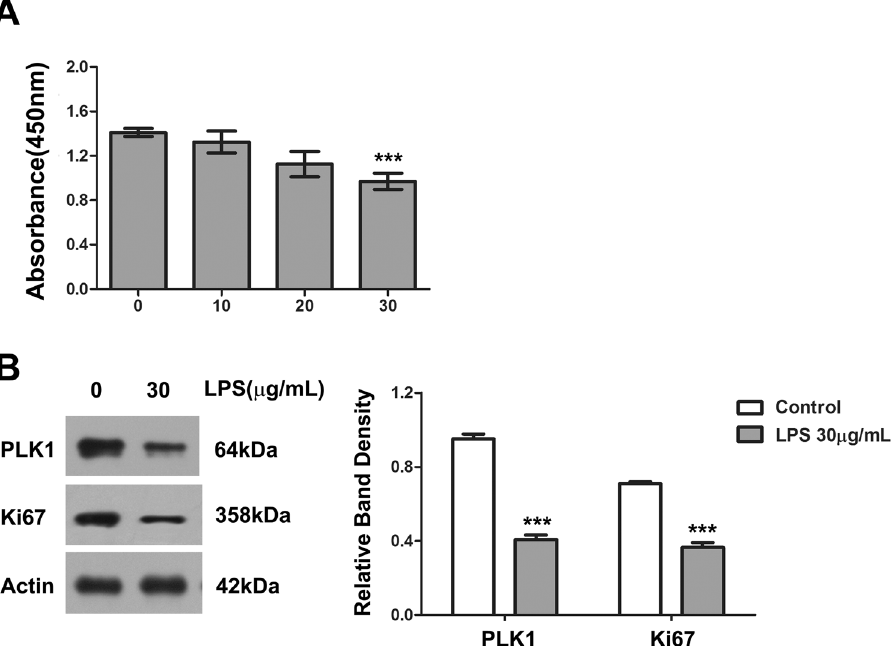
Figure 4. LPS suppresses proliferation in HT29 Cells. ( A ) The cell-proliferative inhibition effect of LPS in HT29 cells (CCK-8 assay). *** P < 0.001 compared with control group. ( B ) The levels of PLK1 and Ki67 in HT29 cells after treatment with 30 μ g/mL LPS for 24 h. The graph represents the relative band densities. Values are mean ± SEM (n = 3). *** P < 0.001 versus control group.